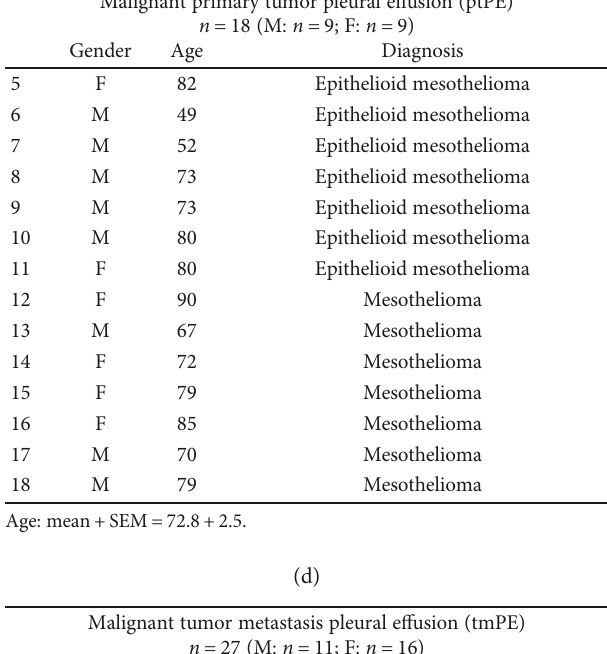
Table 1: Characteristics of all patients with pleural e ff usion analyzed.